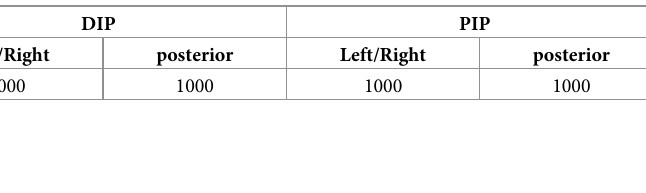
Table 5. Stiffness of the spring unit at the joints.